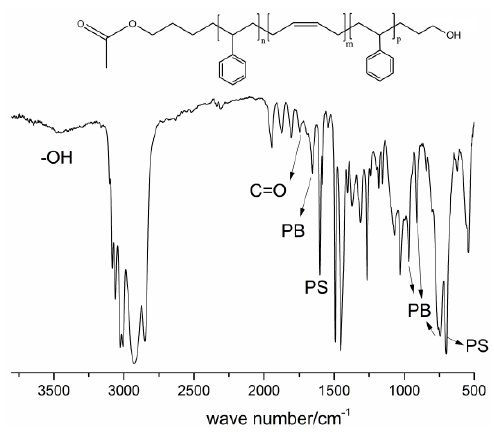
Figure 2. FT-IR of CH 3 COO–SBS–OH, initiator: St:B:St (molar ratio) = 0.02:1:4:1.